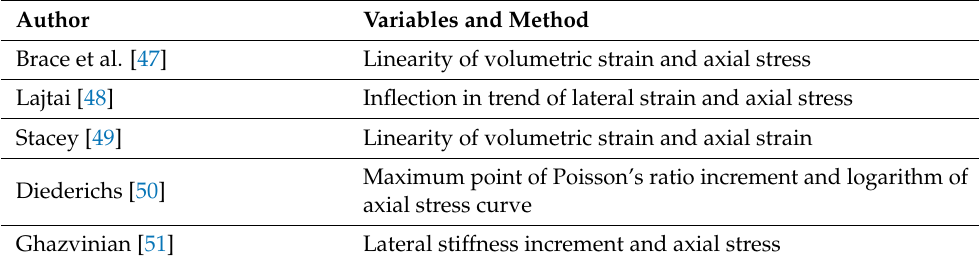
Table 3. List of techniques for determination of Crack Initiation (CI) using strain